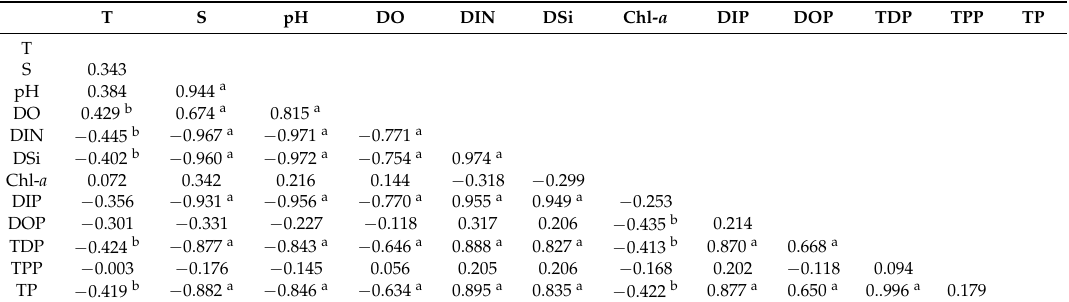
Table 5. Pearson correlation matrix for the P species and physicochemical parameters in the water column of the Dafengjiang River